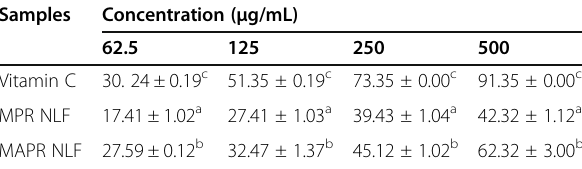
Table 1 Percentage of scavenging activity of MPR and MAPR of NLF against 1, 1-Diphenyl-2-Picryl Hydrazyl Radical (DPPH) Samples